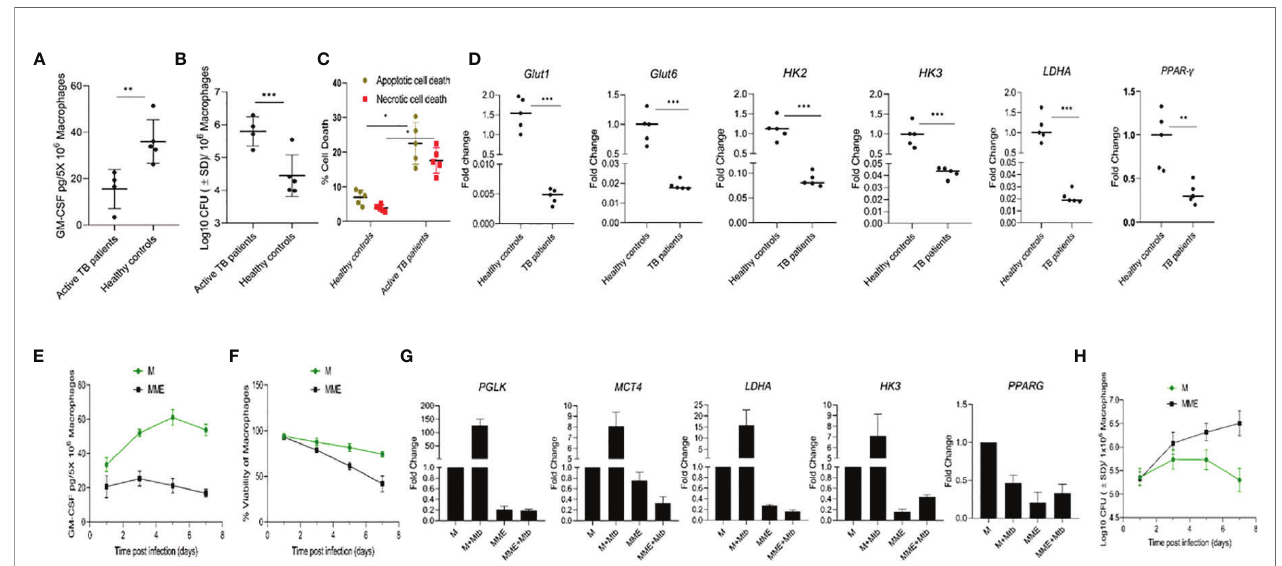
FIGURE 6 | Different levels of GM-CSF production in macrophages of active TB patients and healthy controls and its association with intracellular bacterial control, survival of the host cells, and metabolic state. (A) Secreted levels of GM-CSF by macrophages of active TB patients versus healthy controls post-differentiation and M. tuberculosis infection. GM-CSF levels were measured at day seven post-infection. (B) M. tuberculosis burden in macrophages of active TB patients versus healthy controls post- differentiation measured by CFU assay at seven days after infection. (C) Percentage and proportion of apoptotic and necrotic cell death in M. tuberculosis -infected macrophages of active TB patients versus healthy controls at seven days post-infection measured by fl uorescent microscopy-based apoptotic/necrotic assay. (D) Relative fold change in RNA concentration of speci fi c genes ( GLUT1, GLUT6, HK2, HK3, LDHA , and PPAR- g ) in PBMC-derived macrophages of active TB patients versus healthy subjects as determined by qPCR. Student ’ s t-test was used for means comparison between active TB patients versus healthy subjects. (E) Secreted levels of GM-CSF by M versus MME macrophages at different times post- M. tuberculosis infection. GM-CSF levels were measured in macrophage (5x10 6 ) culture supernatants using sandwich ELISA. (F) Cell viability of M. tuberculosis -infected M versus MME macrophages measured by alamarBlue assay over seven days of infection. (G) Relative fold change in RNA concentration of speci fi c genes ( PGLK, MCT4, LDHA, HK3 , and PPAR- g ) in PBMC-derived macrophages of active TB patients versus healthy subjects as determined by qPCR. Student ’ s t-test was used for means comparison between M versus MME macrophages. (H) M. tuberculosis burden in M versus MME macrophages as measured through CFU assay over seven days of infection. Mtb, M. tuberculosis ; pgs, picograms. Data represent the average of three independent experiments carried out in duplicate. Bars and error bars represent means and SD, respectively. *p ≤ 0.05, **p ≤ 0.005, ***p ≤